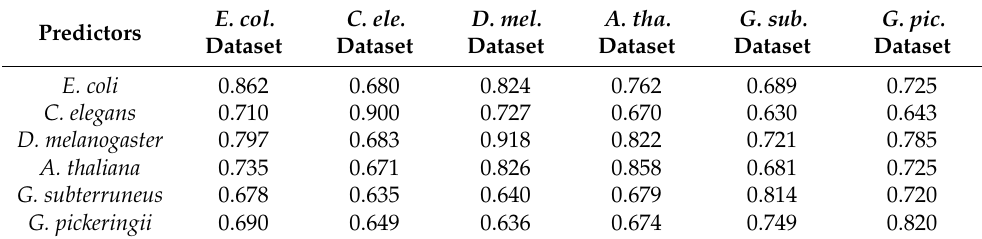
Table 5. The accuracy of predictors for six species in cross-species